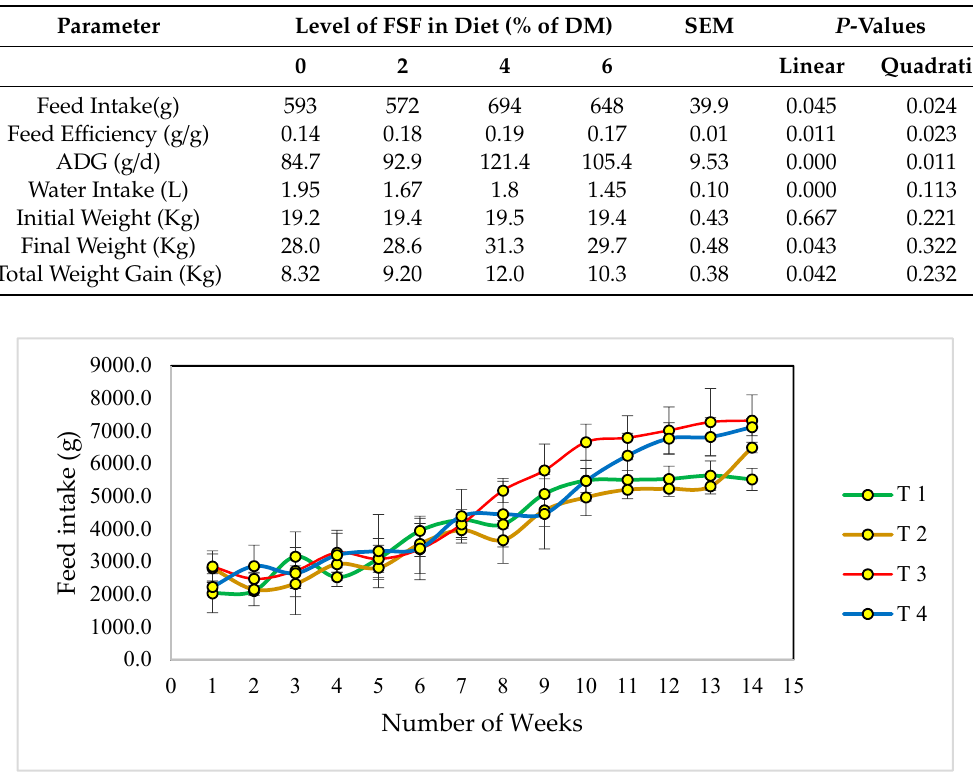
Figure 1. Graphical representation of feed intake of Dohne-Merino wethers fed varying levels of Fossil shell flour (FSF) shown as means ± standard errors. T1: 0% FSF diet; T 2: 2% FSF diet; T3: 4% FSF diet; T4: 6% FSF